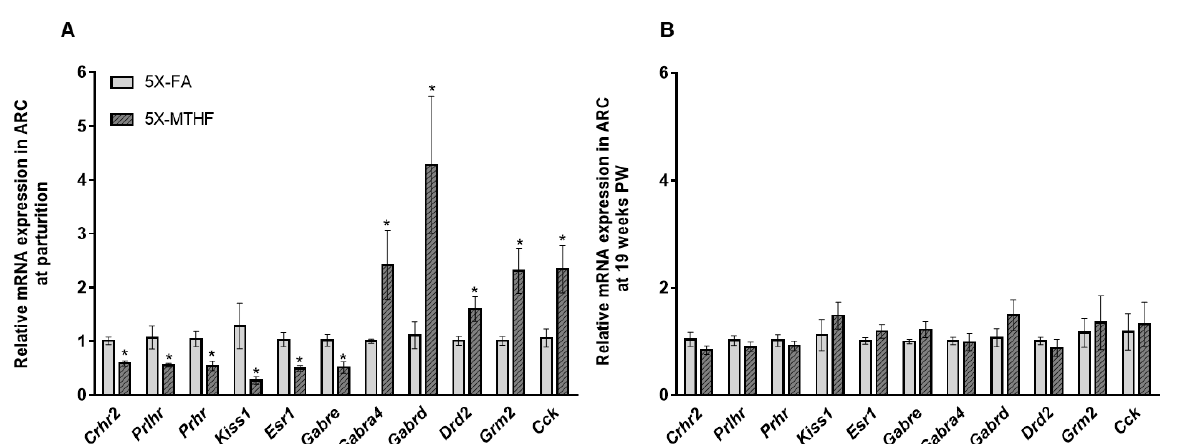
Figure 4. ( A ) Relative mRNA expression of differentially expressed genes identified by RNAseq validated by qRT-PCR in the ARC of 5X-MTHF compared to 5X-FA dams at parturition and ( B ) at 19-weeks post-weaning (PW). n = 5/group at parturition and n = 7/group post-weaning. Values are Means ± S.E.M. Comparisons between 5X-MTHF and 5X-FA groups were analyzed by Student T-test, significance at * p < 0.05. Abbreviations: AIN-93G rodent diet with 5X folic acid (FA) or equimolar [6S]-5-methyltetrahydrofolic acid calcium salt (MTHF) at 5X (10.4 mg/kg) levels. Cck , cholecystokinin ; Crh2 , corticotropin-releasing hormone receptor 2 ; Esr1 , estrogen receptor 1 ; Gaba4a , gamma-aminobutyric acid type A ( Gaba ) receptor alpha ; Gabrd , gaba receptor delta ; Gabre , gaba receptor epsilon ; Grm2 , glutamate receptor 2 ; Kiss1 , kisspeptin ; Prhr , prolactin hormone receptor ; Prlhr , prolactin-releasing peptide .